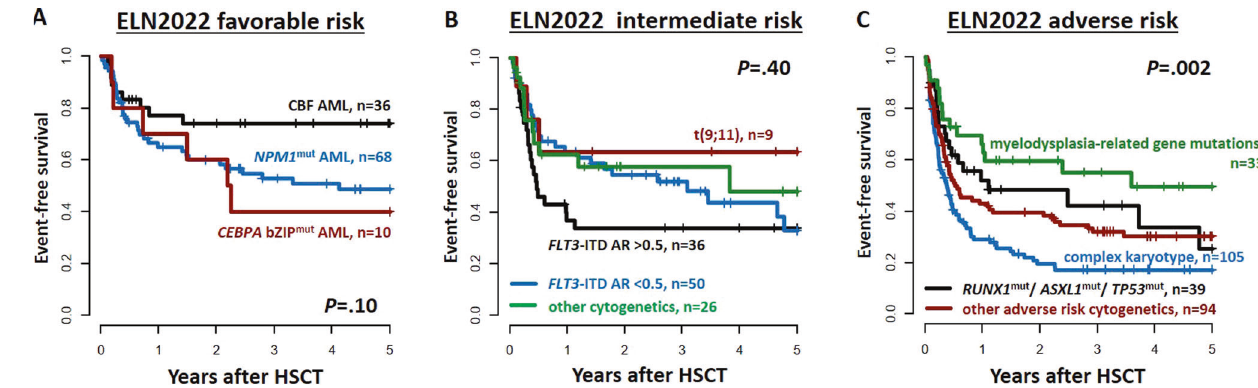
Fig. 3 Event-free survival within the three ELN2022 risk groups at diagnosis according to the different genetic characteristics. A In favorable ELN2022 risk AML patients ( n = 114), B in intermediate ELN2022 risk AML patients ( n = 121), and C in adverse ELN2022 risk AML patients ( n = 271). Note: P values for subgroup comparisons: ELN2022 favorable risk: CBF vs NPM1 mut P = 0.05, CBF vs CEBPA bZIP mut P = 0.09, NPM1 mut vs CEBPA bZIP mut P = 0.70; ELN2022 intermediate risk: FLT3 -ITD AR <0.5 vs FLT3 -ITD AR >0.5 P = 0.30, FLT3 -ITD AR >0.5 vs t (9;11) P = 0.20, FLT3 -ITD AR >0.5 vs other cytogenetics P = 0.20, FLT3 -ITD AR <0.5 vs t (9;11) P = 0.30, FLT3 -ITD AR <0.5 vs other cytogenetics P = 0.70, t (9;11) vs other cytogenetics P = 0.50). ELN2022 adverse risk: ELN2017 de fi ned high-risk mutations vs myelodysplasia-related gene mutation P = 0.30, ELN2017 de fi ned high-risk mutations (i.e., mutations in the genes: ASXL1 , RUNX1 , and TP53 ) vs complex karyotype P = 0.02, ELN2017 de fi ned high-risk mutations vs other adverse risk karyotypes P = 0.40, myelodysplasia-related gene mutation vs complex karyotype P <